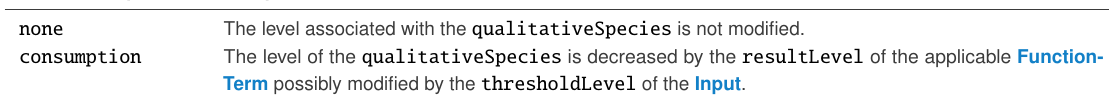
Table 1: Interpretation of the transitionEffect attribute on an Input . Note: as discussed in Section 3.6.3 on page 14 the ’applicable FunctionTerm ’ refers to whichever FunctionTerm in the ListOfFunctionTerms evalutaes to “ true ” or the DefaultTerm if all of the FunctionTerm objects evaluate to “ false